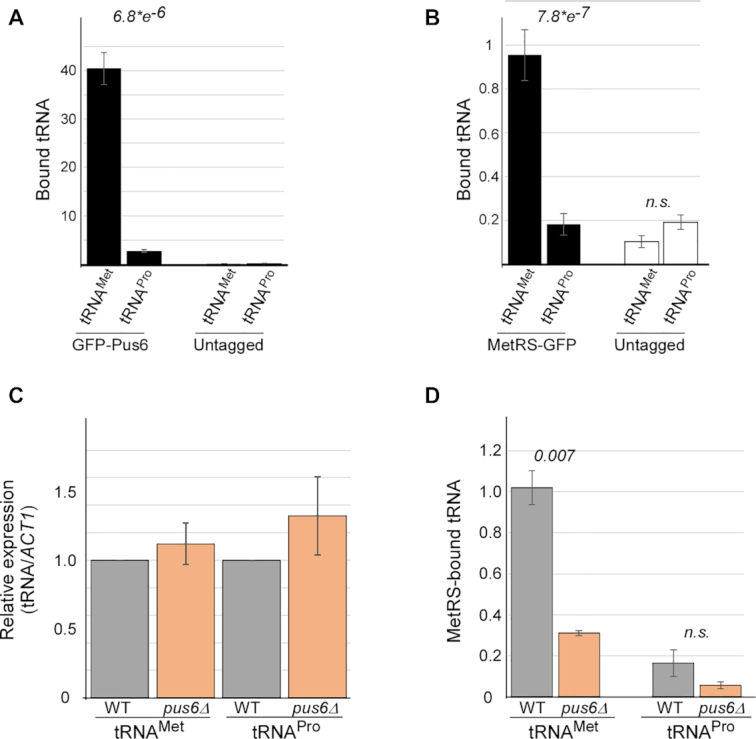
Pus6 mediates MetRS binding to elongator tRNAMet. (A) GFP-tagged Pus6 strain and a control untagged parental strain were subjected to RIP. Indicated tRNAs were quantified by tRNA-adapted RT-qPCR (35) for the Input and IP samples. Numbers on bars are binding efficiency (IP samples normalized to the corresponded Input). Data are from two independent biological repeats. P-value was calculated by the dependent samples one-tailed t-test. (B) GFP-tagged MetRS strain and a control untagged parental strain were subjected to RIP. Indicated tRNAs were quantified by tRNA-adapted RT-qPCR for the Input and IP samples and analyzed as in A. Data are from two independent biological repeats. P-value was calculated by the dependent samples one-tailed t-test. (C) Steady-state levels of the indicated tRNAs from cells either containing (WT) or deleted of Pus6 (pus6Δ) were measured by RT-qPCR analysis (35) and normalized to ACT1. The histogram presents the quantification of three independent biological repeats. (D) GFP-tagged MetRS cells either containing (WT) or deleted of Pus6 (pus6Δ) were subjected to RIP and bound tRNA levels were quantified. The histogram presents the quantification of three independent biological repeats. P-value was calculated by the dependent samples one-tailed t-test.